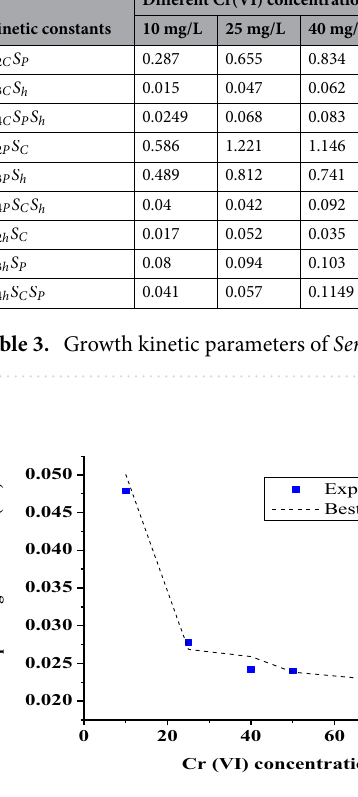
Figure 5. Growth kinetic modelling in tertiary substrate